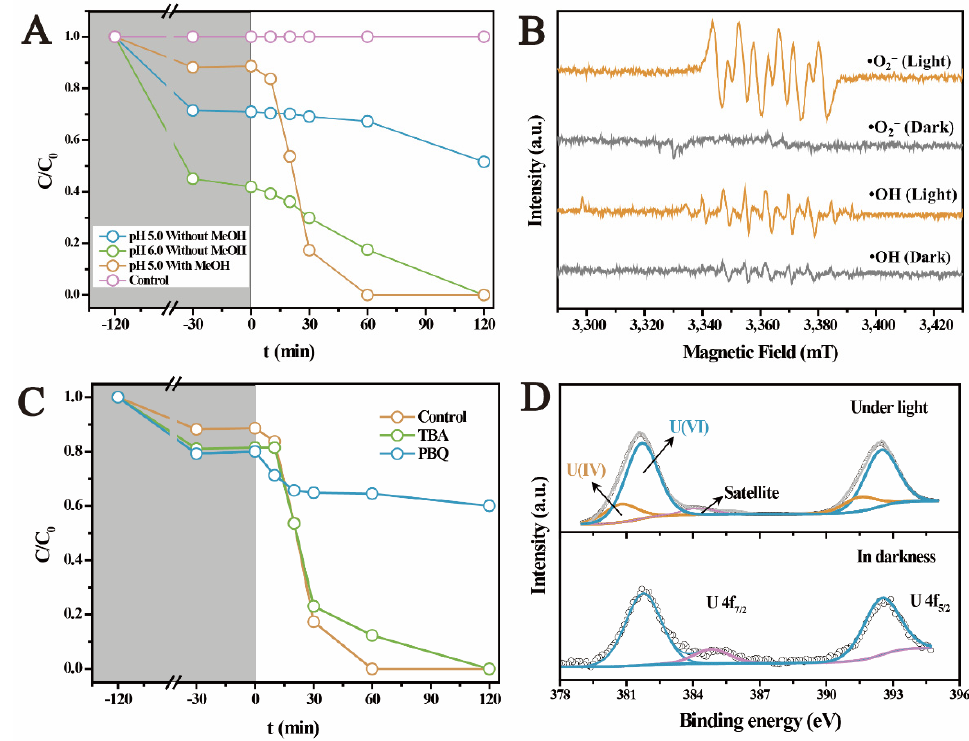
Figure 2. The photocatalytic reduction of U(VI) by ferrihydrite under anaerobic conditions ( A ), ESR spectra of •OH and •O 2 − radicals ( B ), the photocatalytic kinetics of U(VI) on ferrihydrite by the addition of PBQ (scavenging•O 2 − ) and TPA (scavenging •OH) ( C ), and U 4f XPS spectra for the products after adsorption and photocatalytic reaction ( D